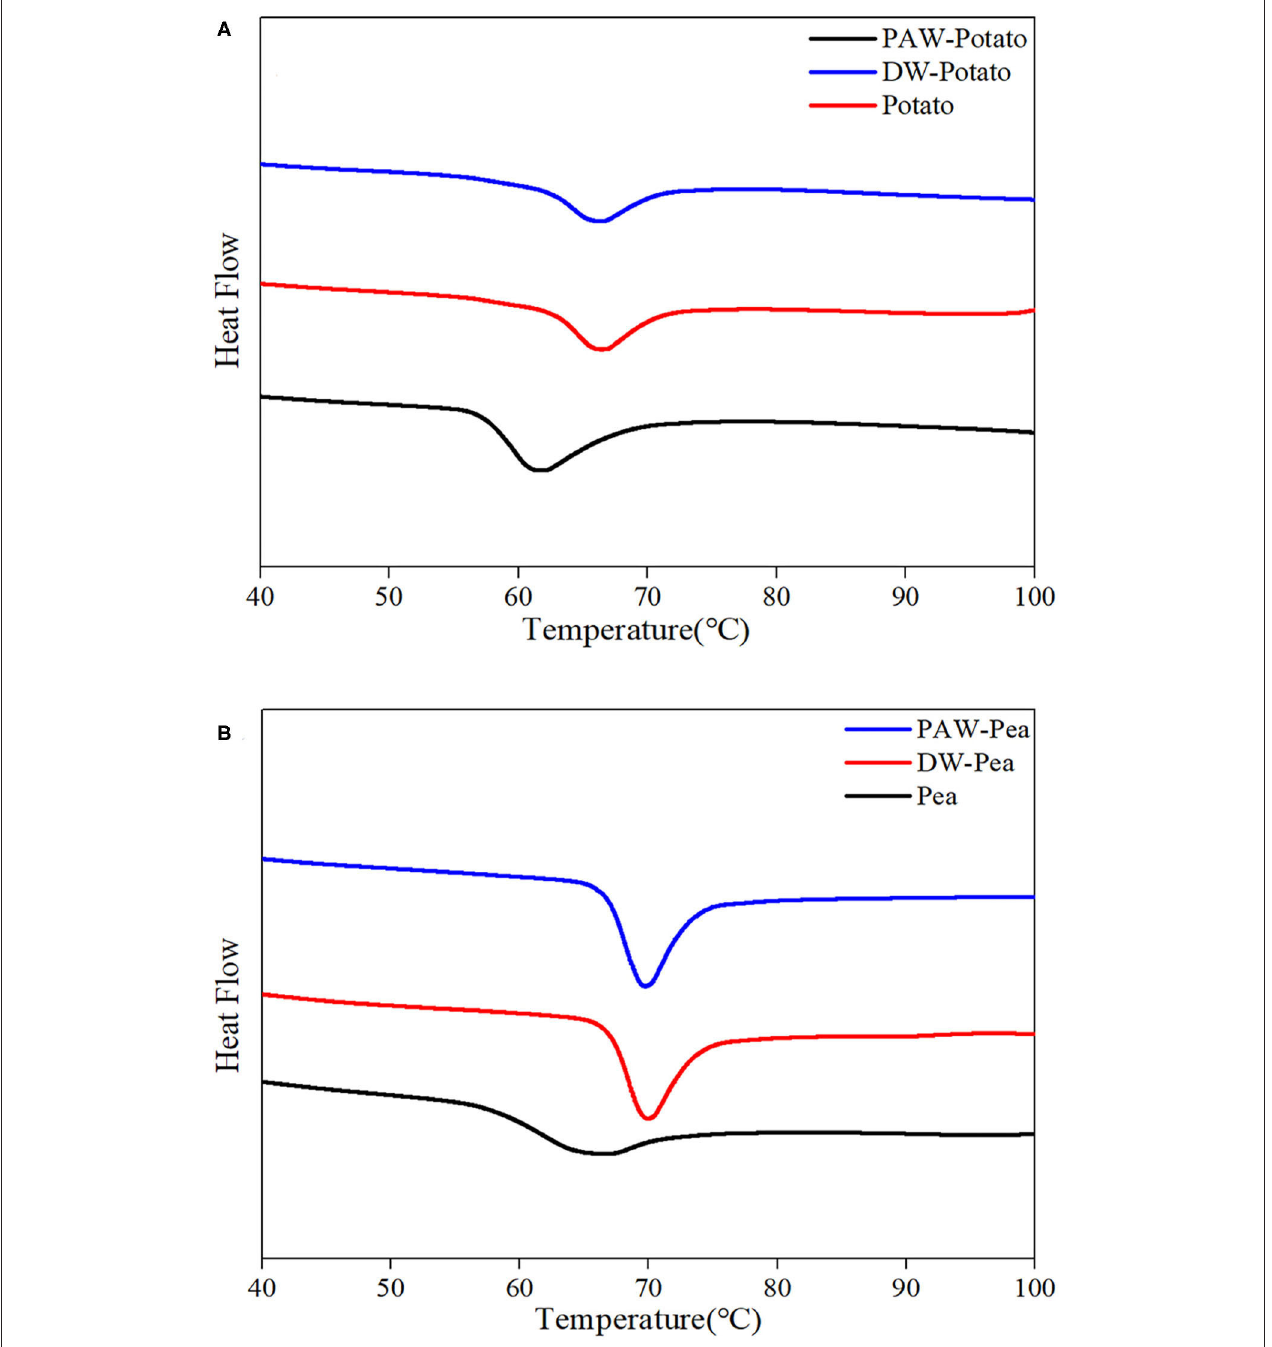
FIGURE 5 | Thermal properties of native and modified starches. (A) Native, DW-ANN treated, and PAW-ANN treated potato starch. (B) Native, DW-ANN treated, and PAW-ANN treated pea starch.